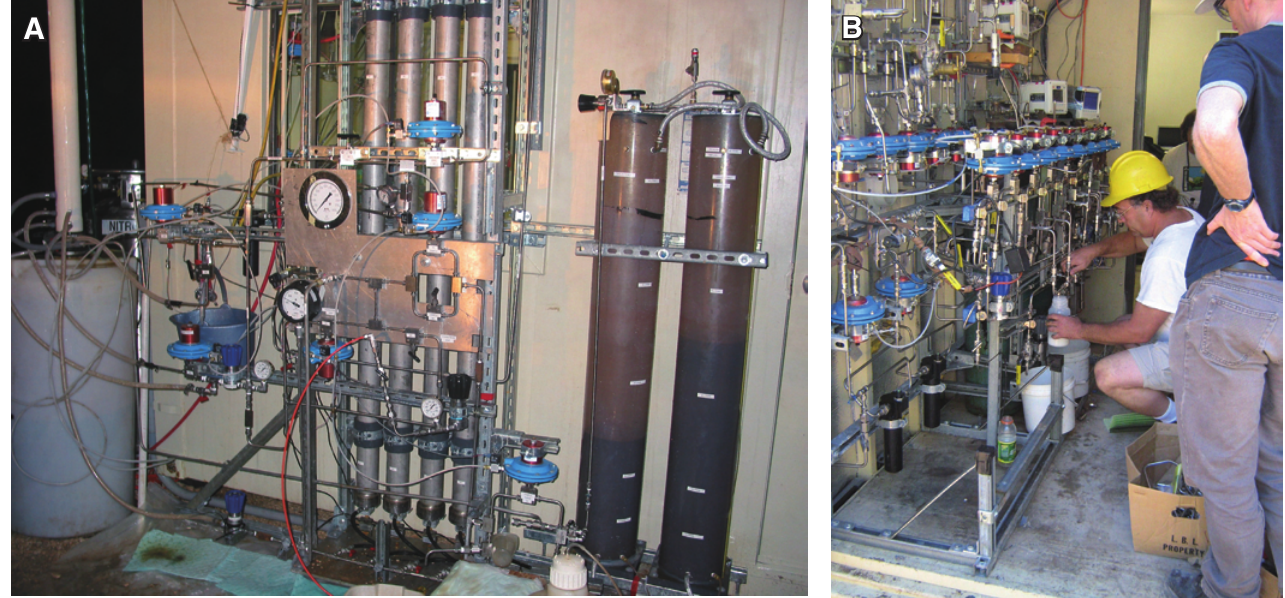
Figure 2. The Frio Brine Pilot surface sampling systems: [A] Four 13 L high pressure sample vessels mounted in sliding sleeves and resting on strain gauges to measure fluid density. [B] Computer-operated valve manifolds used to operate the U-tube samplers.